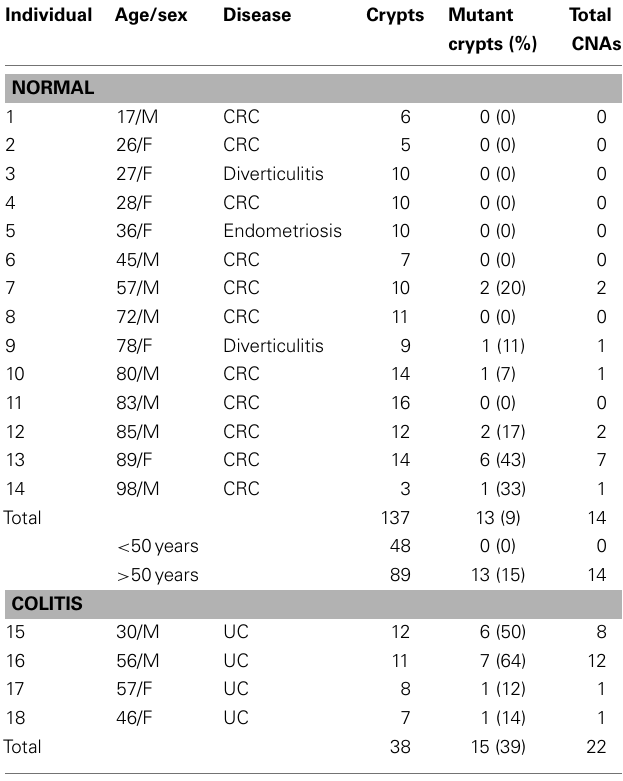
Table 1 | Colon crypt chromosome copy number